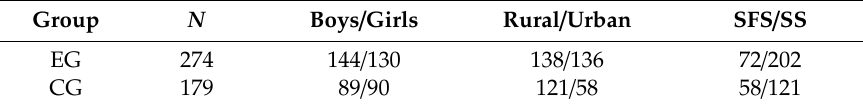
Table 1. Sample composition by sex and school